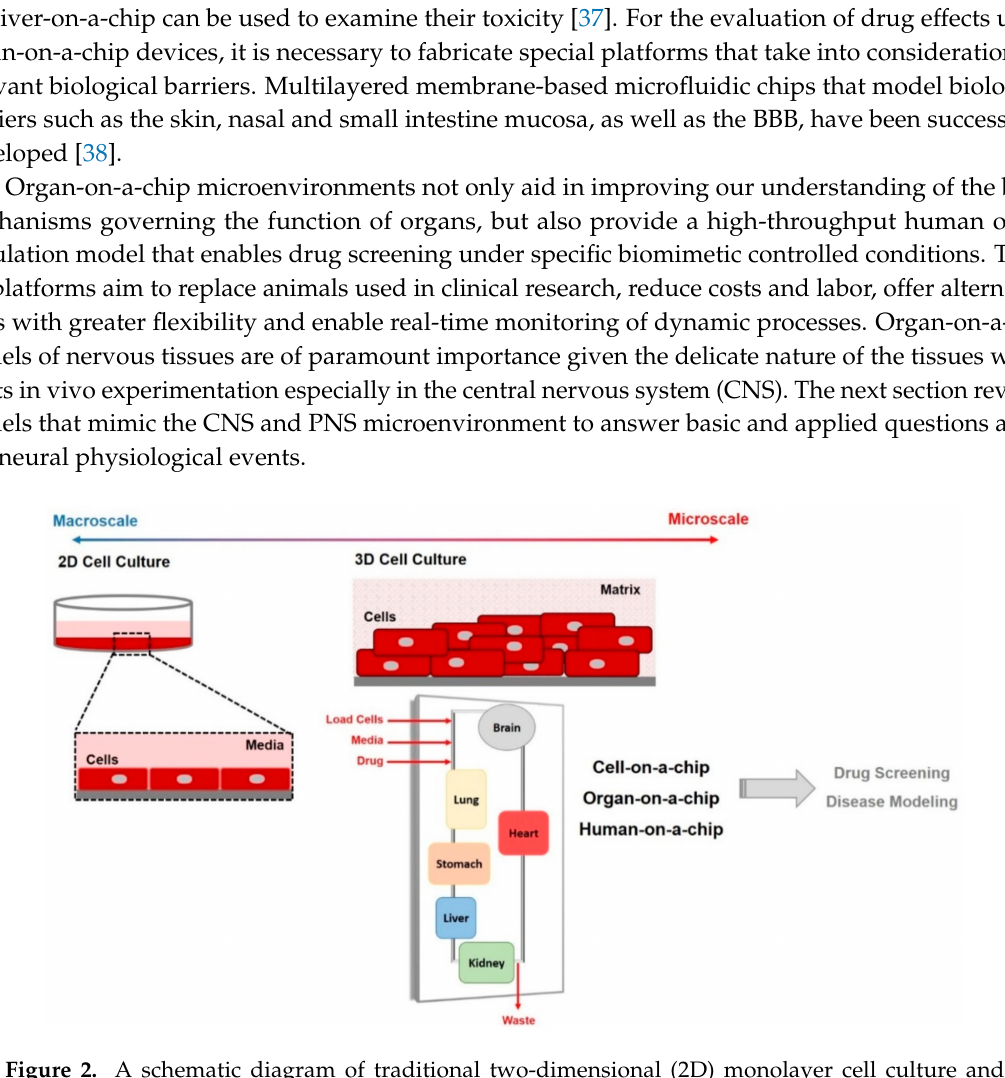
Figure 2. A schematic diagram of traditional two-dimensional (2D) monolayer cell culture and three-dimensional (3D) microfluidic cell culture systems. Table 1. Differences between two-dimensional (2D) and three-dimensional (3D) culture systems